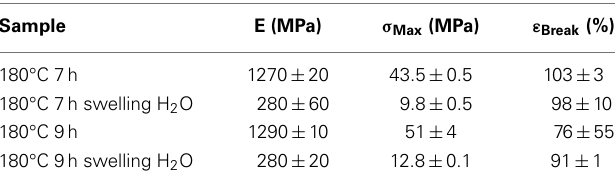
Table 2 | SPEEK samples treated for 7 and 9h at 180°C before and after swelling in water at 25°C for 24h .